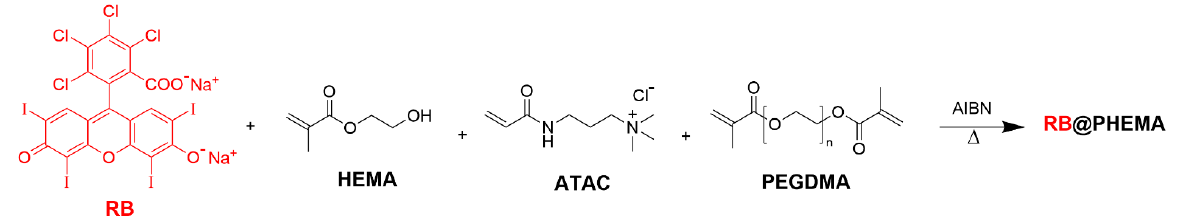
Figure 1. Structures of photosensitizer RB and monomers ( HEMA , ATAC ) and crosslinker ( PEGDMA ) used to synthesize RB @PHEMA. RB